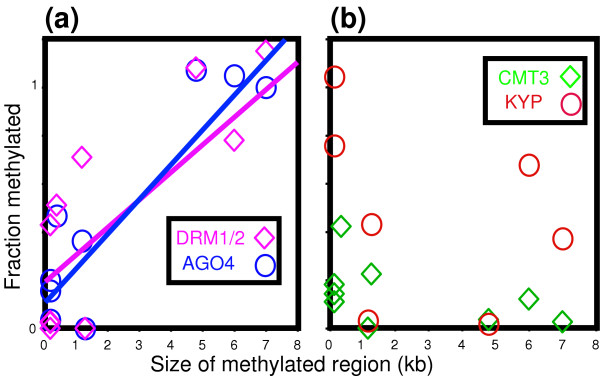
Methylation by DRM1/2 and AGO4 is associated with the size of their targets. (a) The loss of methylation for each locus is calculated from the reduction seen in drm1/2 and ago4 when measured by bisulfite sequencing (drm1/2: correlation coefficient r = 0.82, p < 0.003; ago4: r = 0.90, p = 0.0002). The fraction methylated is the ratio of mutant to wild-type percentages listed in Table 3. Regression lines are shown for clarity. (b) A similar comparison of CMT3 and KYP reveals no significant associations (cmt3: r = -0.48, p = 0.2; kyp: r = -0.32, p = 0.5), so no regression lines are shown. The comparisons include data reported in this study supplemented with previously published data for other loci [11,12].